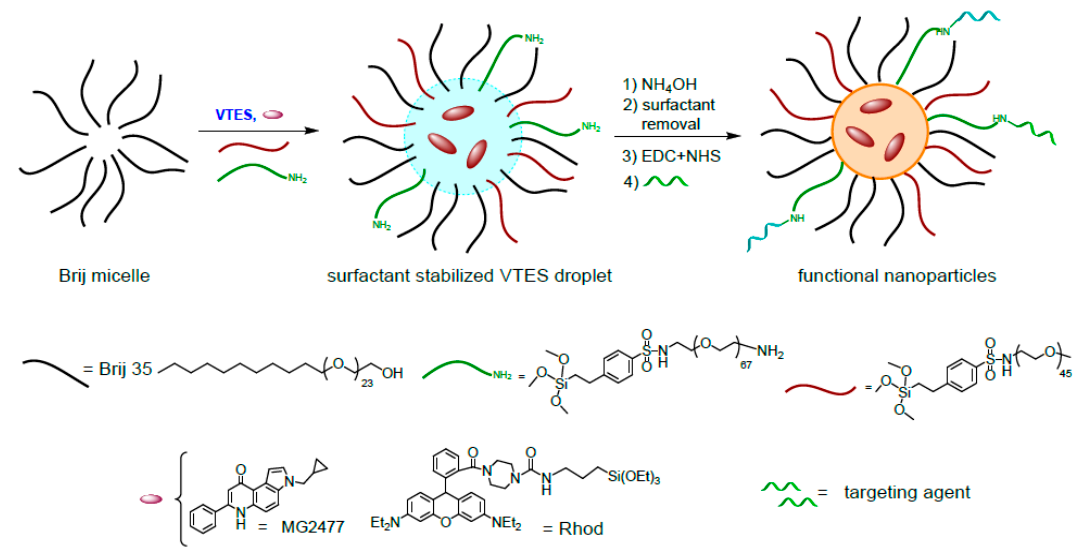
Figure 1. One-pot synthesis of doped, PEGylated, and functional organic-modified silica (ORMOSIL) nanoparticles (NPs). Nanoparticles will be named in the paper according to the following code: surface groups-loaded species = NP, where NP indicates a PEGylated ORMOSIL nanoparticle. VTES = vinyltriethoxysilane; NHS = N-hydroxysuccinimide.